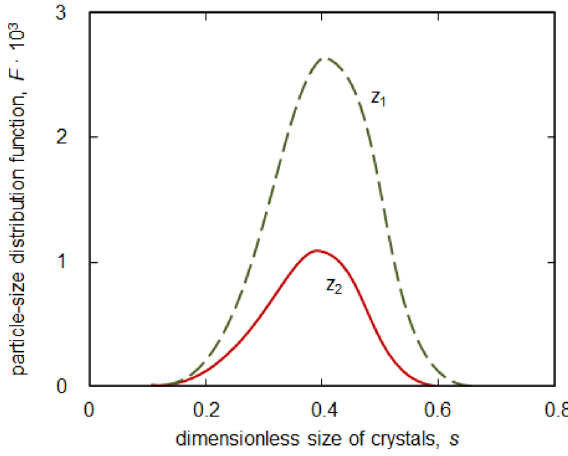
0.5 ) and z 2 0.9 10 4 ( w = = ×